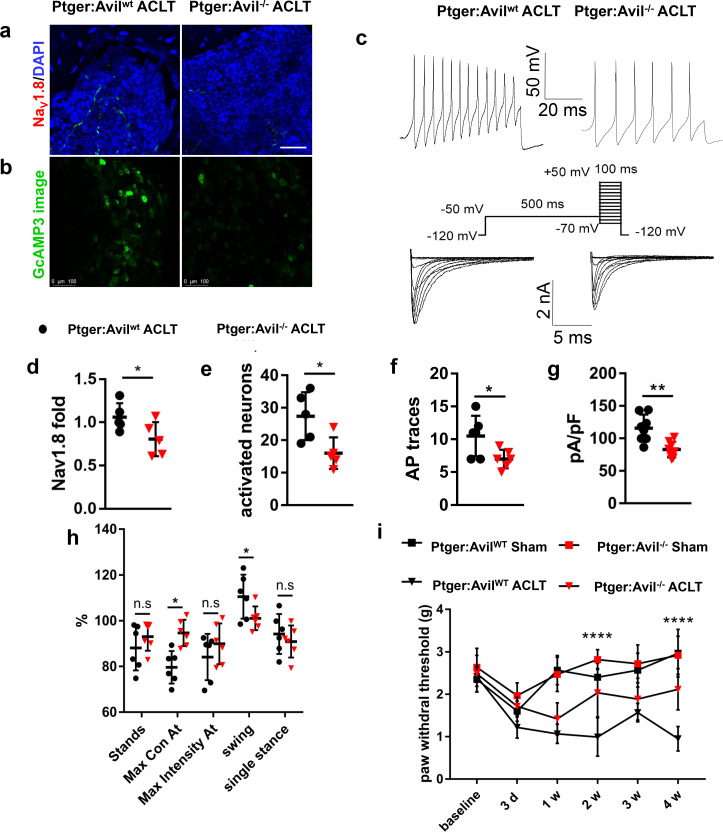
Decreased NaV1.8 expression and ameliorated mechanical allodynia in Avil-Cre::Ptger4fl/fl ACLT mice.(a, b) NaV1.8 immunostaining in subchondral bone (a), Activated neurons in ipsilateral L4 DRG using in vivo Pirt-GCaMP3 imaging (b) after sham or ACLT surgery at 1 m. Scale bars, 20 μm (a), 100 μm (b). (c) Representative traces of action potentials (upper) and Nav1.8 currents (lower) of ipsilateral L3-5 DRG neurons after sham or ACLT surgery at 1 m. (d–i) Statistical analysis of Nav1.8 immunofluorescence signal in subchondral bone (d), number of activated neurons in ipsilateral L4 DRG using in vivo Pirt-GCaMP3 imaging (e), AP traces (f), max Nav1.8 current density (g), catwalk gait analysis (h) and left hindpaw PWT (i) after sham or ACLT surgery. n = 6 per group, *p<0.05, **p<0.01, ***p<0.001, ****p<0.0001 compared with the sham-operated group at different time points. Statistical significance was determined by multifactorial ANOVA WITH BONFERRONI POST HOC TEST (i) or unpaired Student’s t test (d–h), and all data are shown as scattered plots with means ± standard deviations.Figure 3—source data 1.Raw data of subchondral Nav1.8 fiber density, Von Frey tests, catwalk analysis, GcAMP3 imaging, and electrophysiological recordings.